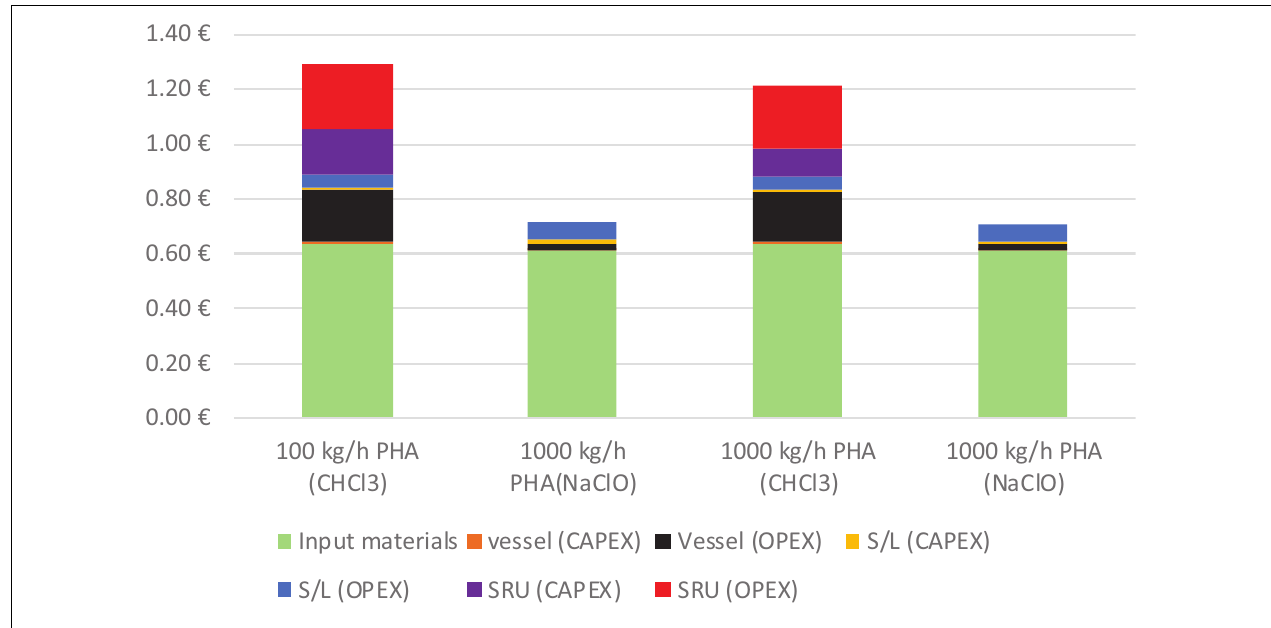
FIGURE 3 | Analysis of major sources of costs of two PHA extraction processes (extraction with CHCl 3 and cellular lysis with NaClO).